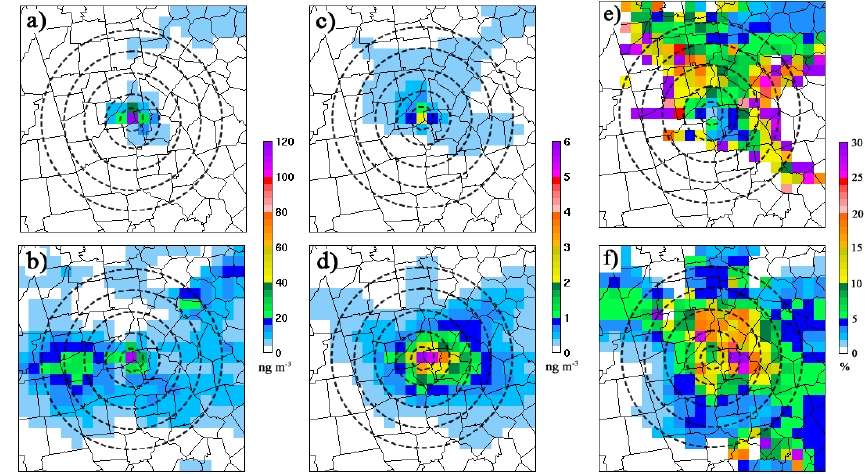
Figure 4. Monthly average contributions from aircraft to PM 2 . 5 in (a) January and (b) July, to non-traditional SOA (NTSOA) in (c) January and (d) July, and NTSOA ( > 0.1ngm − 3 ) as a percentage of aircraft-attributable PM 2 . 5 in (e) January and (f) July. Note the differences in scales, that the absolute maximum impacts occur in the grid cell containing ATL but the percentage of aircraft-attributable PM 2 . 5 comprised of NTSOA is higher away from the airport, and that the map covers an area of 720km × 720km. Circles indicate the location of ATL and 30, 54, 78, and 102km away from ATL.